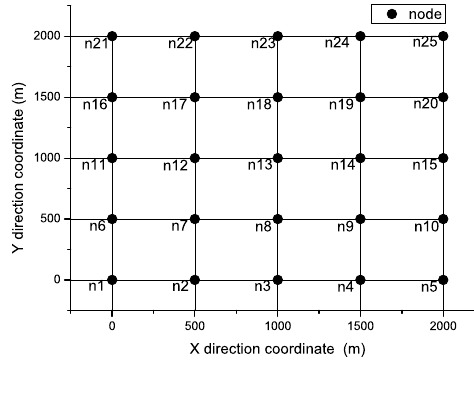
Fig. 1. The nodes Topological